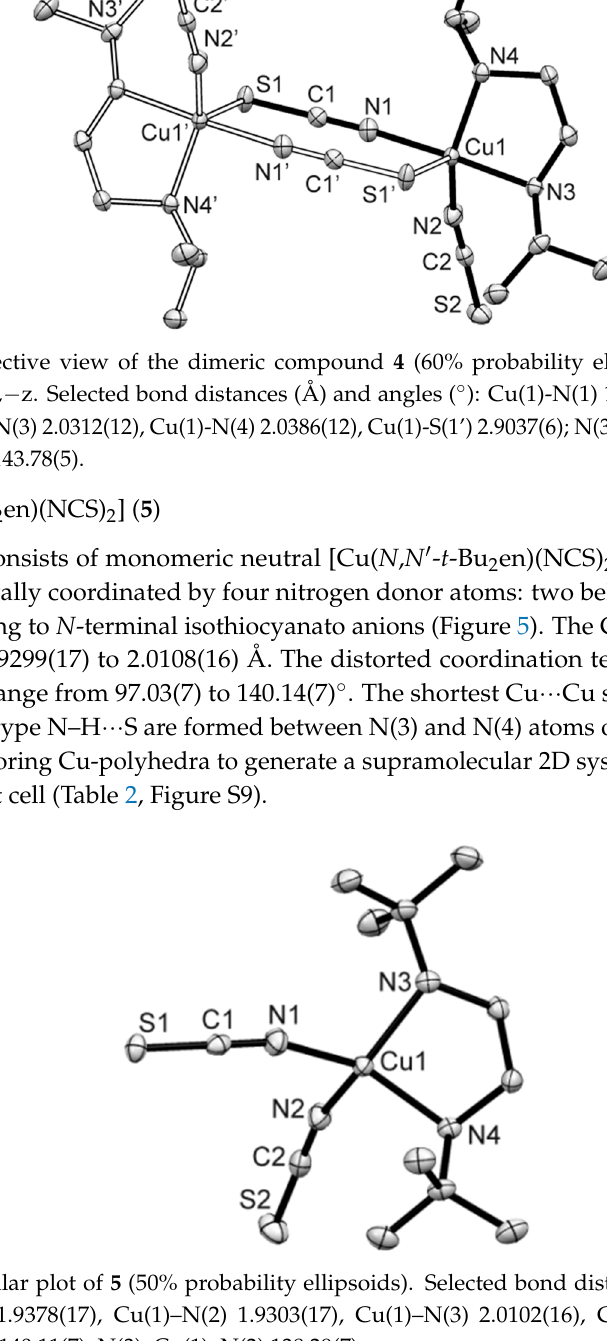
Table 2. Possible hydrogen bonds in crystal structures 1 – 5.